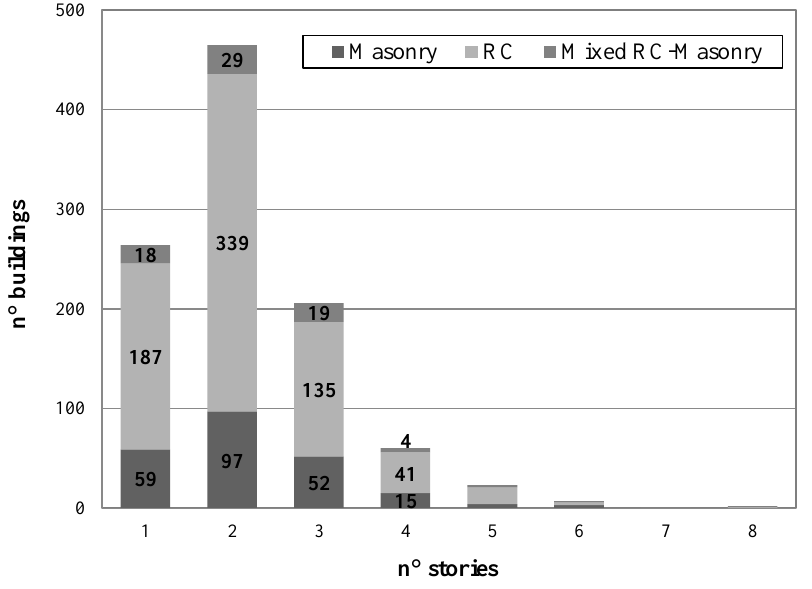
Figure 6. Distribution of the number of stories for the dataset of 1028 buildings.